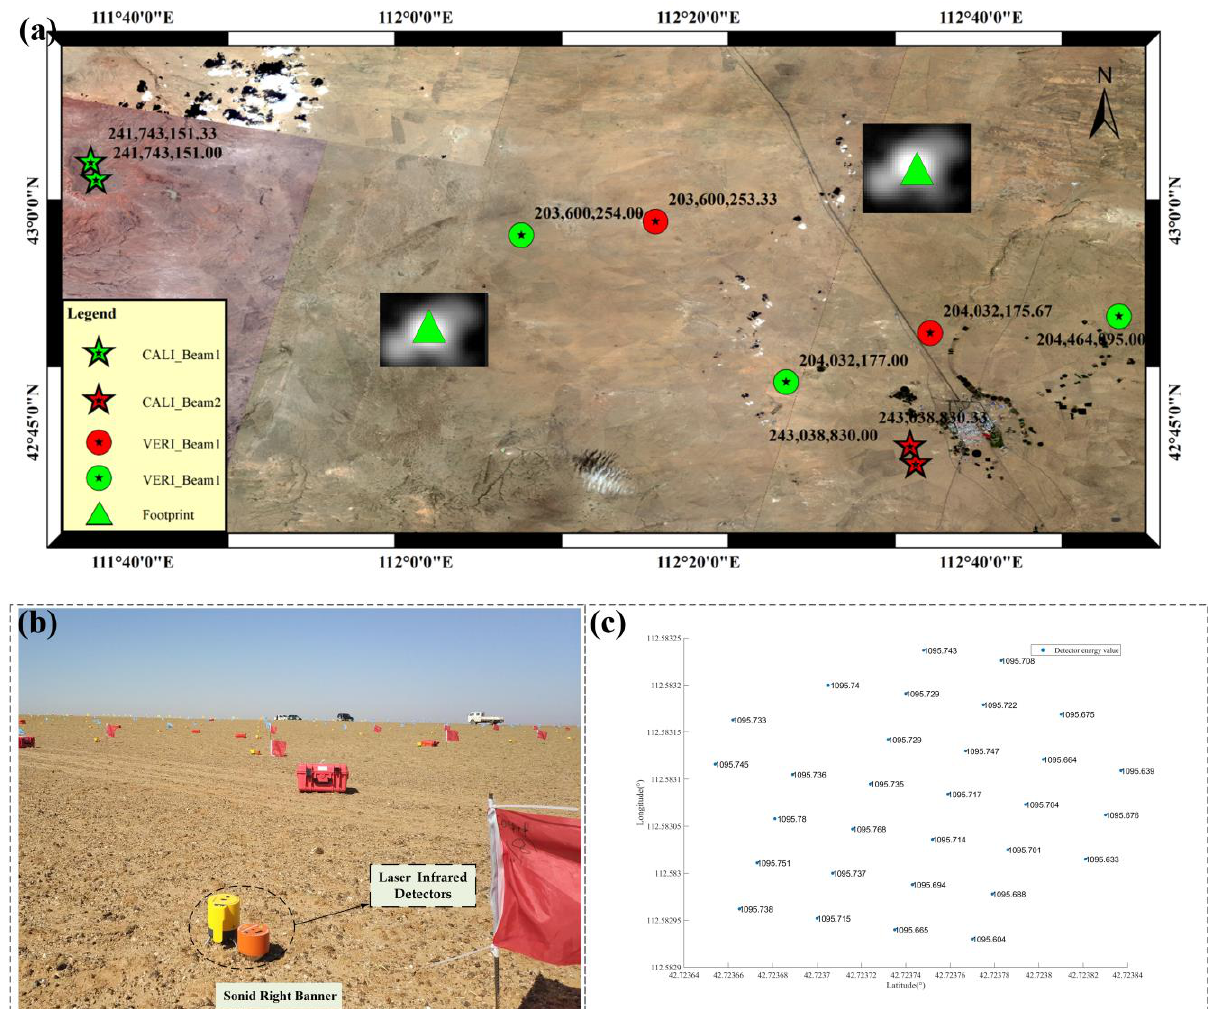
Figure 2. Laser calibration experimental field and data distribution. ( a ) Calibration experimental field and experimental data. ( b ) Infrared detectors. ( c ) Laser spot captured by infrared detectors.